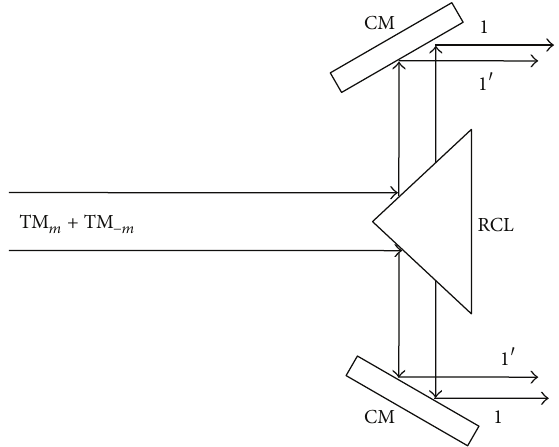
Figure 12: Basic scheme of obtaining of conical beams. RCL is a reflective conical lens, CM is a conical mirror, 1 and 1 󸀠 are extreme rays of the formed conical